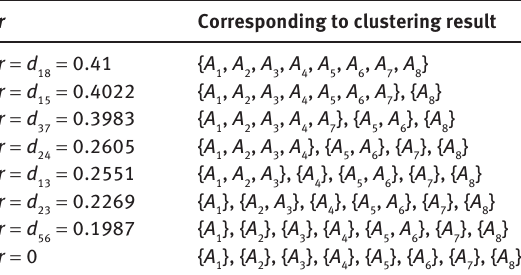
Table 1. SVNMST Clustering Results of the Eight Different